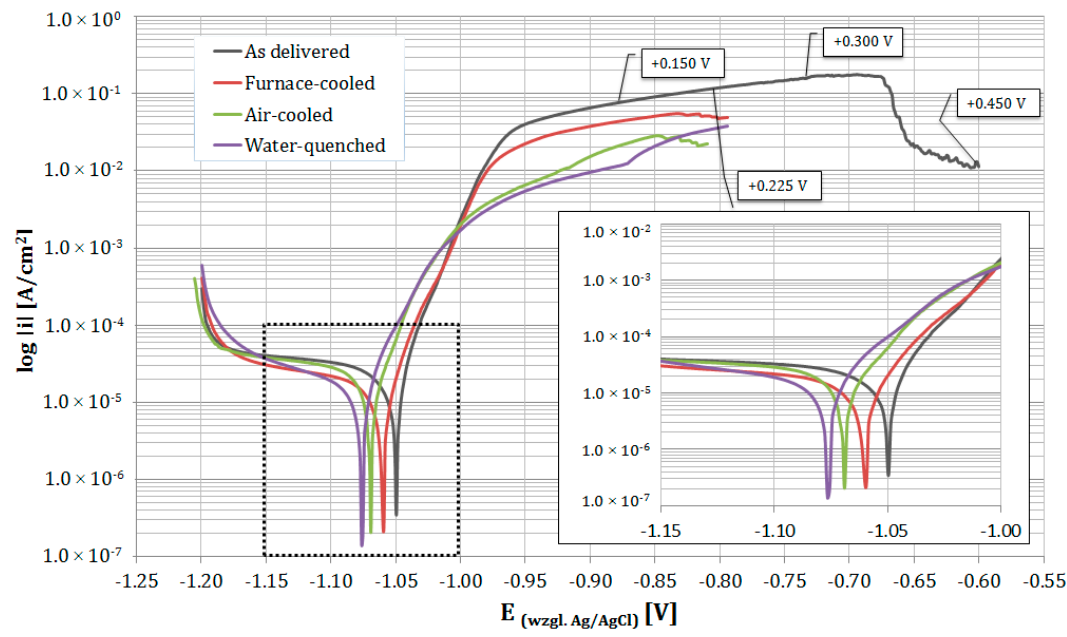
Figure 6. Example potentiodynamic polarization curves of the as-delivered Zn-4Al alloy and heat-treated at 300 ◦ C in 5% NaCl solution. In the curve of the sample polarized to the highest potential value, the potential values (relative to E corr ) were marked where polarization was stopped. Table 2. The electrochemical parameters obtained for as delivered samples, as well as samples heat- treated at 300 °C and subjected to different cooling rates.